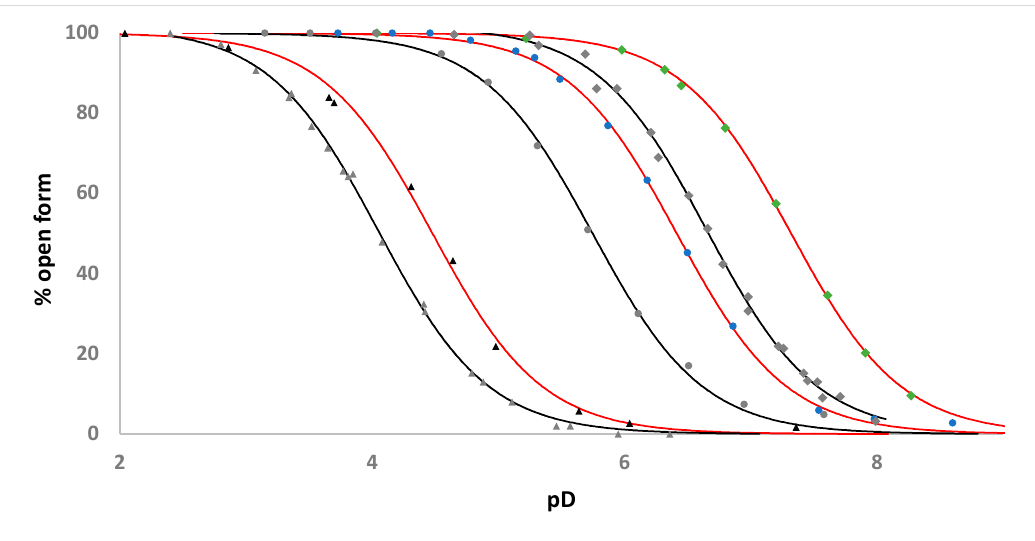
Figure 8. pH dependence of intramolecular sulfonamide ligation for 1 (green diamonds), 2 (blue circles), 3 (black triangles) and the analogous [Ru( η 6 -C 6 H 5 CH 2 CH 2 NHR)(C 2 O 4 )(H 2 O)] complexes [Ru( η 6 -C 6 H 5 CH 2 CH 2 NHTf)(C 2 O 4 )(H 2 O)] (grey triangles), [Ru( η 6 -C 6 H 5 CH 2 CH 2 NHTr)(C 2 O 4 )(H 2 O)] (grey circles) and [Ru( η 6 -C 6 H 5 CH 2 CH 2 NHMs)(C 2 O 4 )(H 2 O)] (grey diamonds) (2.46 mM complex, D 2 O, 295 K, 0.1 M NaCl). pD values are determined using pD = pH meter reading + 0.4 [20]. The solid lines represent the fit of the Henderson-Hasselbalch equation to each set of experimental data.